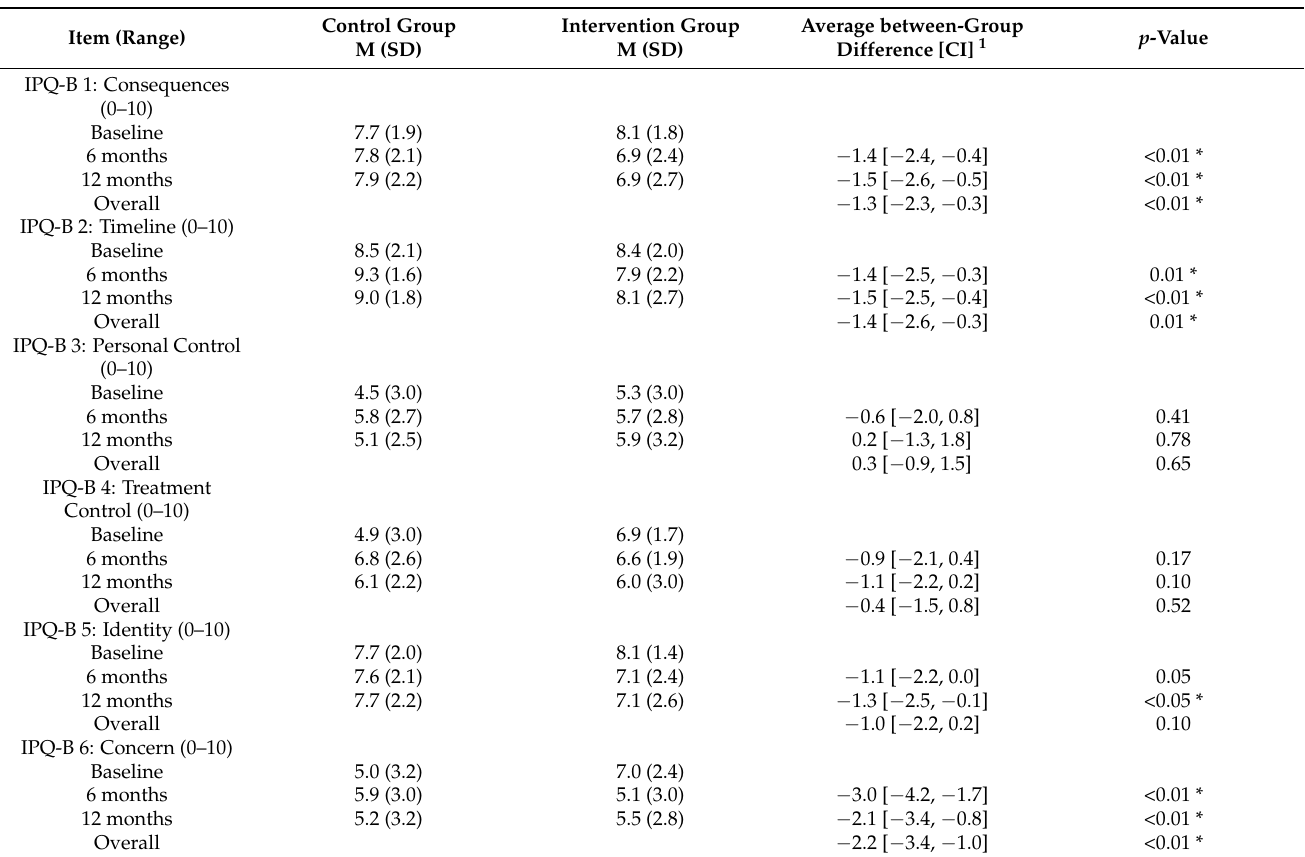
Table 5. Hoc Analysis on IPQ-B a and HADS b